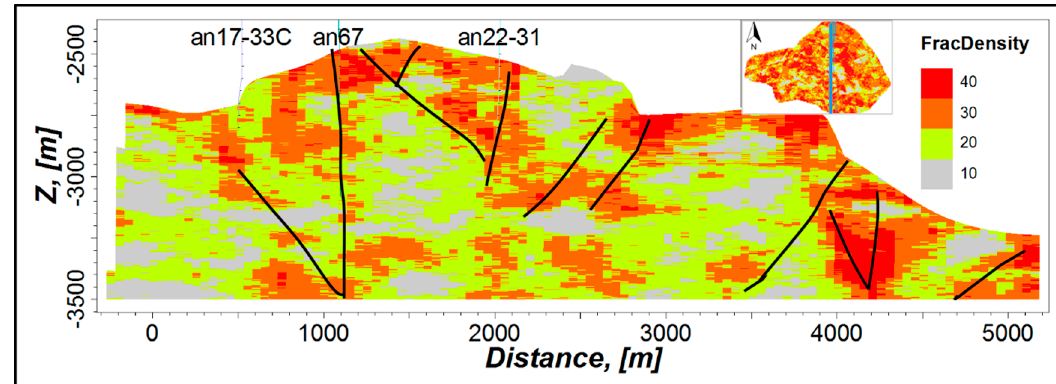
Figure 13. Vertical profile of fracture density. Black lines indicate the faults. The location section is shown in the small inset figure, which shows the fracture density distribution on the top grid in the model.